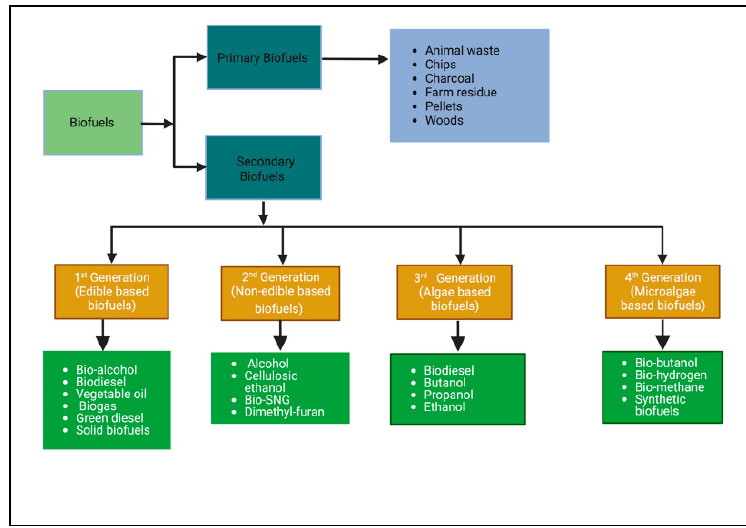
Figure 1. Types and generations of Biofuel. Adopted from [23].